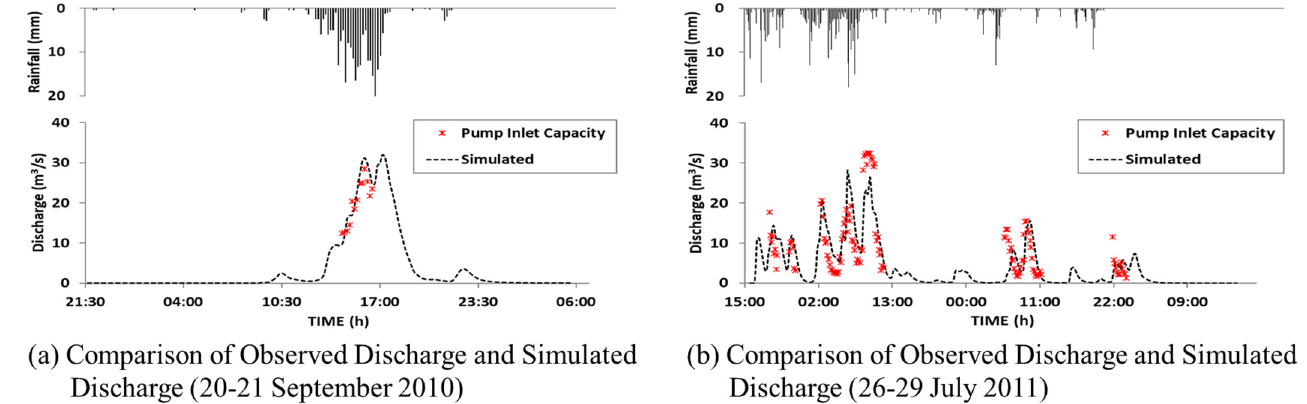
Figure 10. Input parameters estimation of the Dorim 1 watershed.